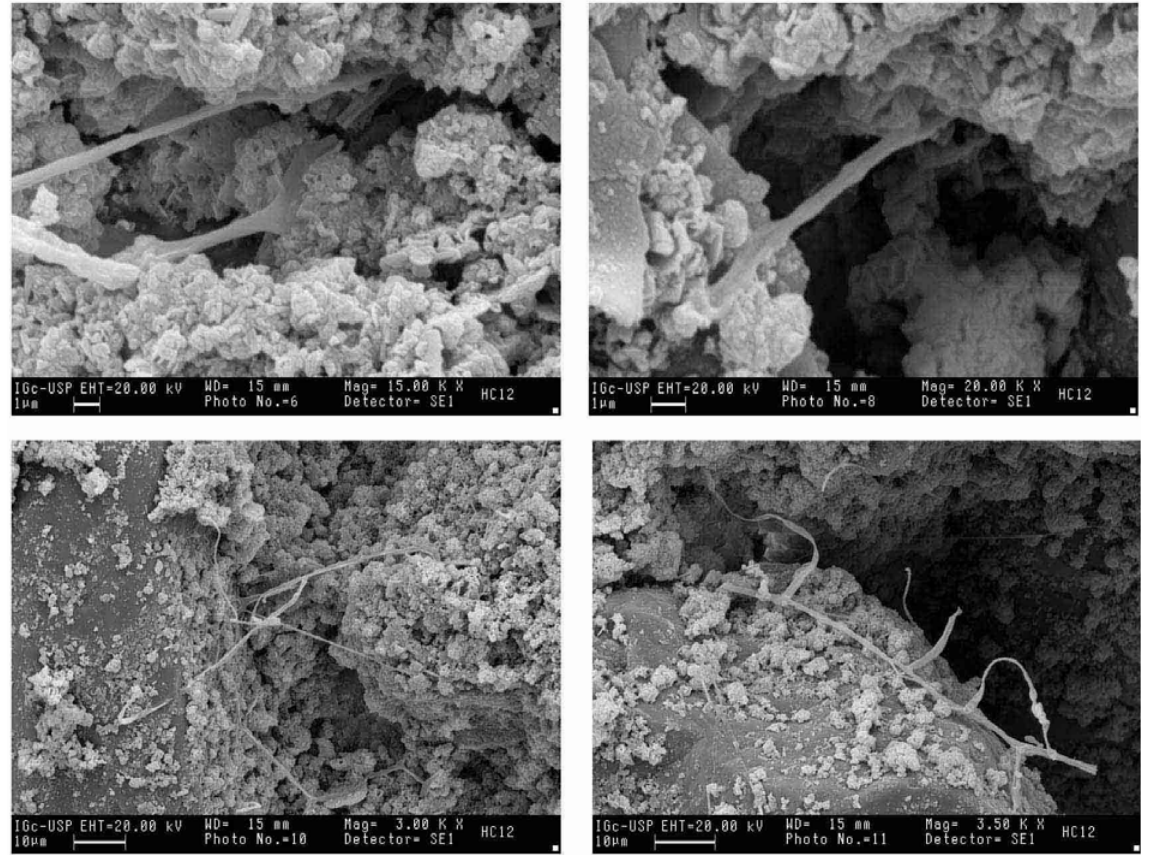
Fig. 3 – SEM images of fibrous materials used by Pennacchi to increase the mortar